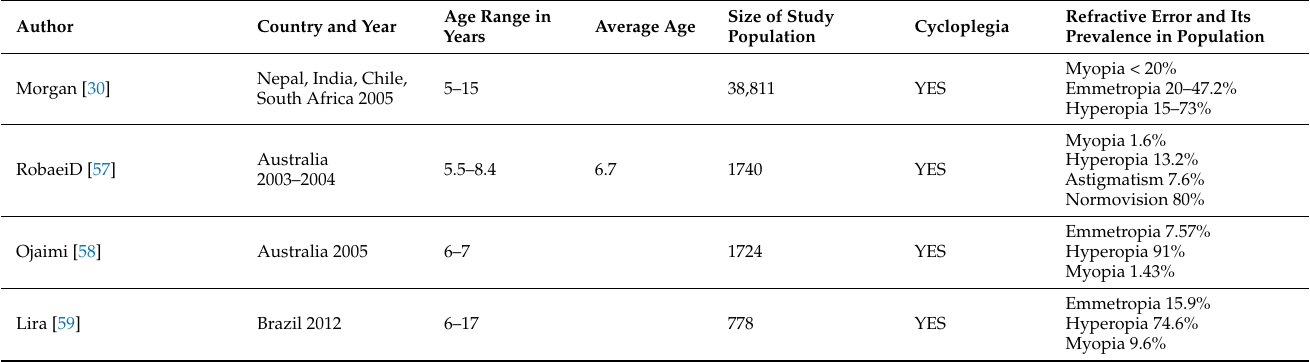
Table 3. Prevalence of refractive errors in children worldwide, according to the literature